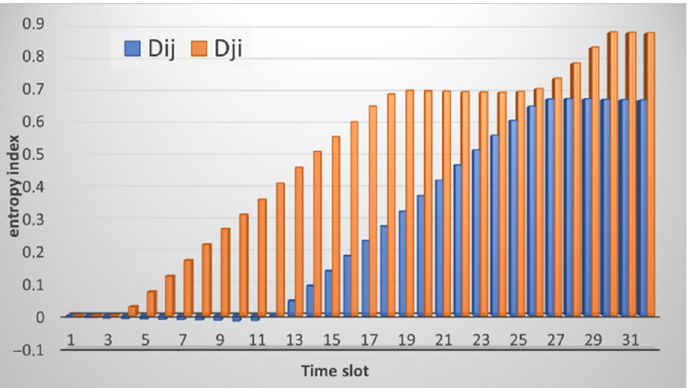
Figure 13. The result of calculating the entropy for CPU load by node i relative to node j (marked in blue) and by node j relative to node i (marked in orange) under conditions of a SYN flood attack.